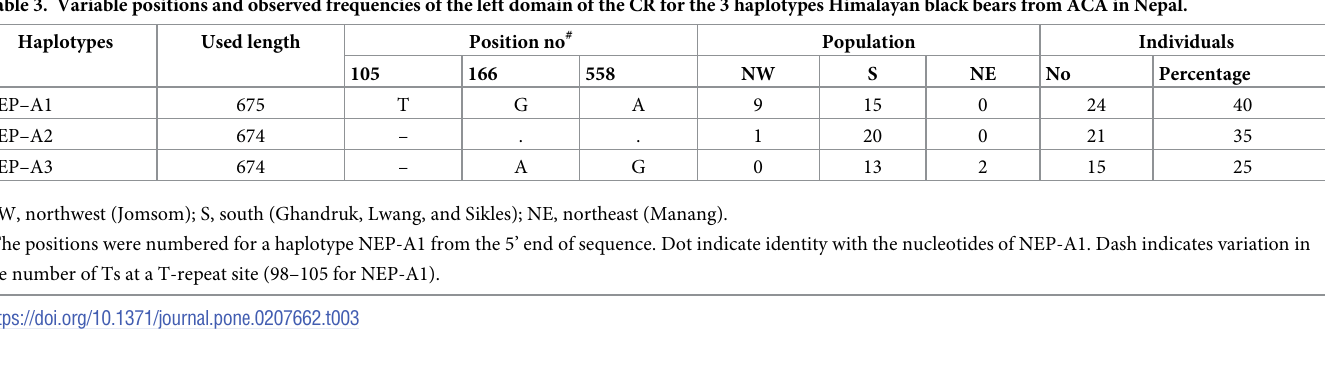
Table 3. Variable positions and observed frequencies of the left domain of the CR for the 3 haplotypes Himalayan black bears from ACA in Nepal. Haplotypes Used length Position no # Population Individuals